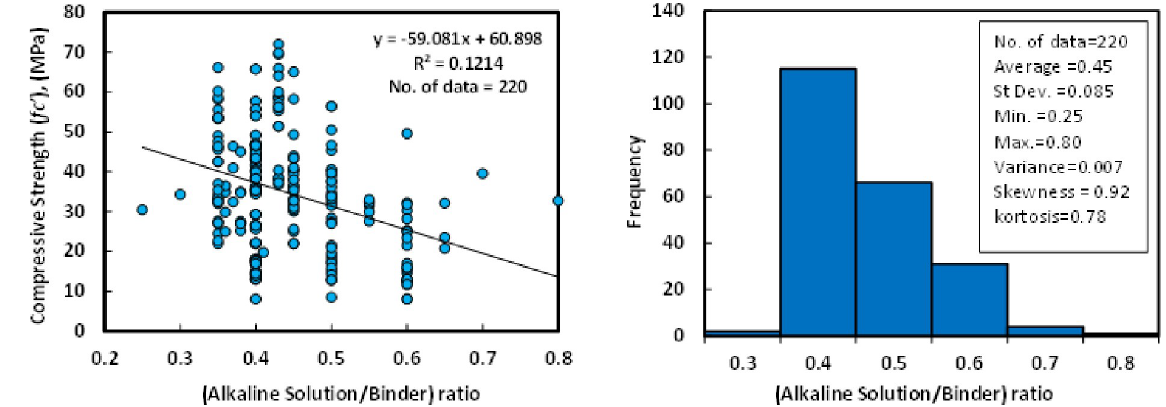
Fig 2. Relationship and a histogram of compression strength and alkaline solution/binder of GGBS/FA-GPC mixtures.